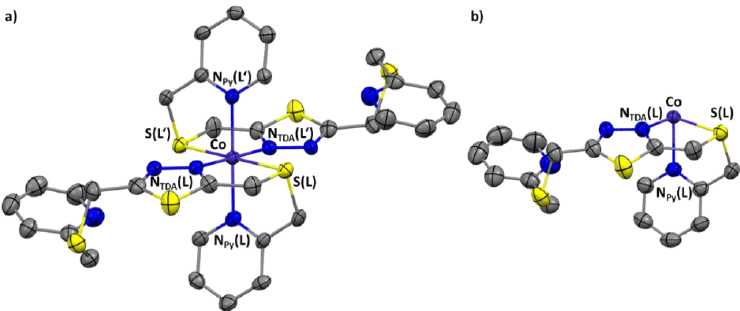
Figure 4. Crystal structures of the complex cations of C2 (asymmetric unit) with thermal ellipsoids at ( a ) 120 K and ( b ) 250 K. Hydrogens, solvent molecules and counter ions have been omitted for clarity. Color code: Co is dark blue, N blue, S yellow, and C grey.